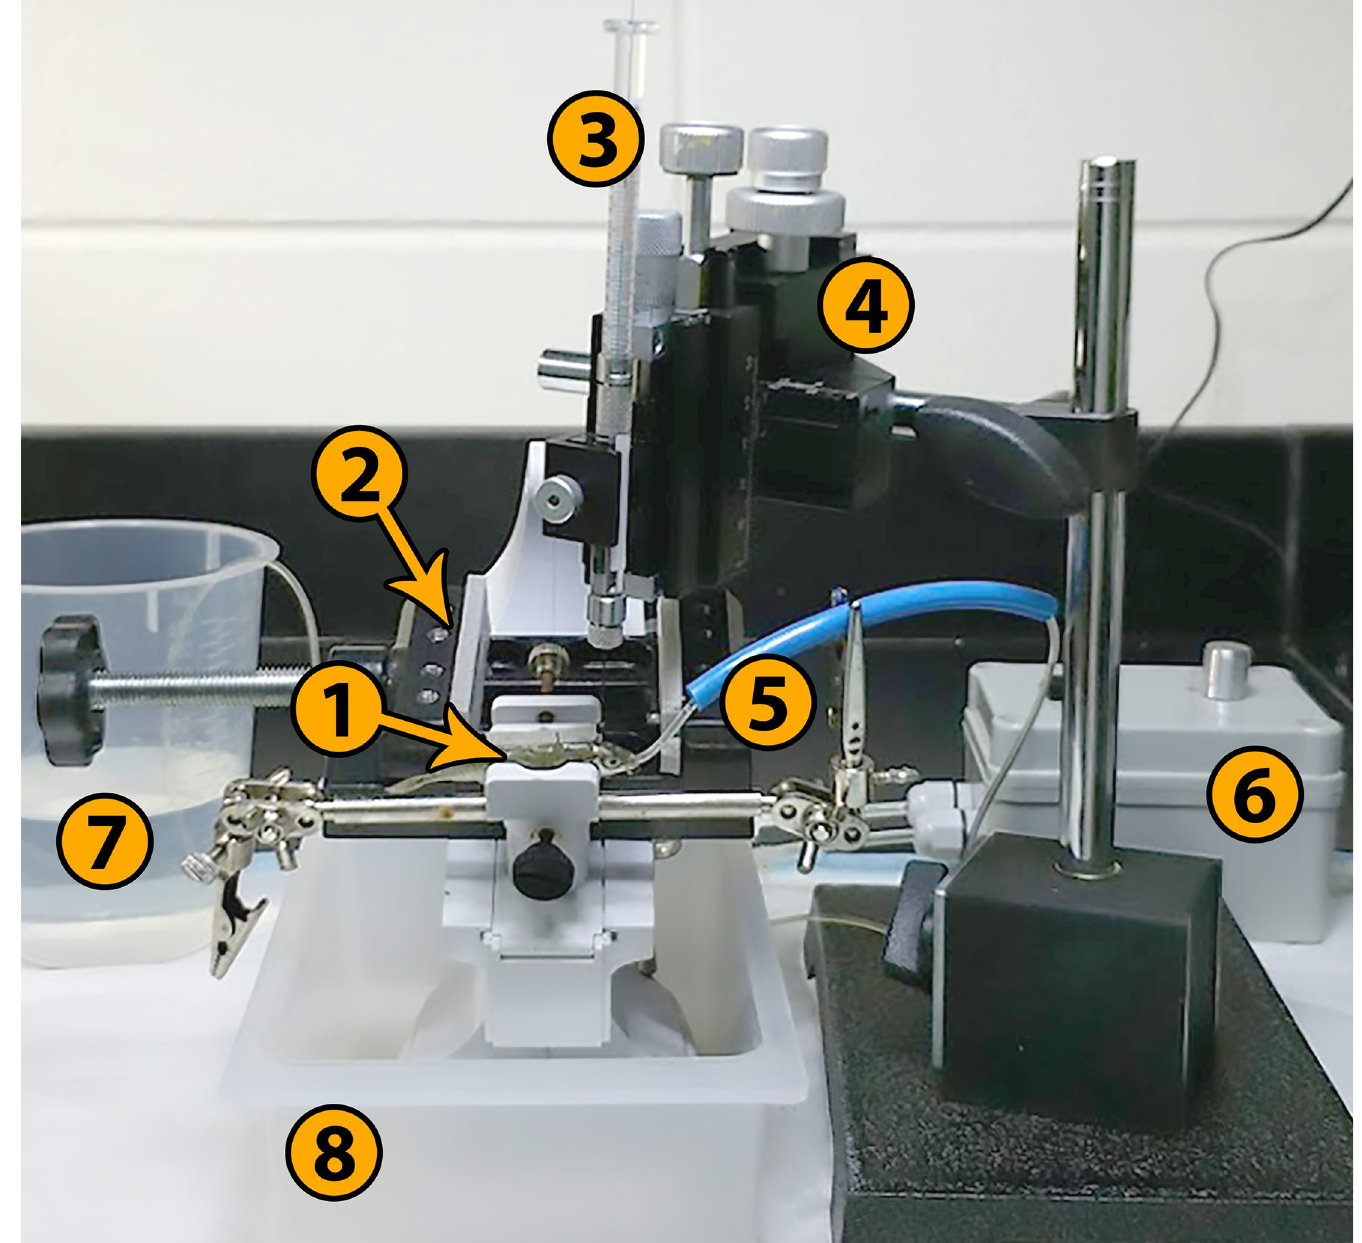
Fig 1. Custom-built surgical rig. 1. Threespine stickleback in padded. Clamp. 2. Alternative padded clamp for larger fish. 3. Neuros syringe, 5 μ L. 4. Three-axis manipulator. 5. Oral cannula and guide tube. 6. Peristaltic cannula pump, 100 mL/min. 7. Pump source reservoir. 8. Drip tray.